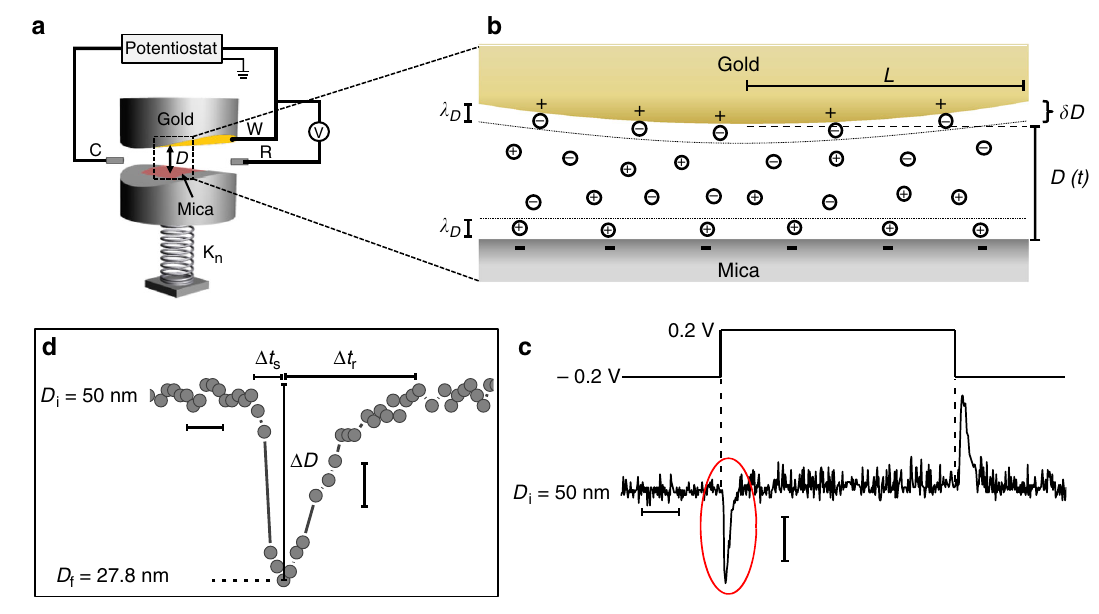
Fig. 1 a Schematic of the Surface Force Balance (SFB) and three-electrode con fi guration, with the principle components labeled, as described in detail in the experimental section. During measurements, the electrodes are immersed in an electrolyte solution inside a quartz bath, custom-designed to prevent leakage of current to the ground. Potentials applied to the gold surface were in the so-called double-layer range (i.e., where the electrode is ideally polarized), to ensure, crucially, the absence of any electrochemical reactions 44,45 (Supplementary note 5). b A section through the intersurface gap at closest separation D , showing its pore-like structure, where λ D is the Debye length, L is the radius of the circular pore, δ D is the change in pore width at a distance L from the pore center due to curvature of the surfaces ( δ D ≅ L 2 /2 R ). The schematic is not to scale: L is typically 100 μ m, while D is of order 100 nm, giving a (diameter/thickness) ratio of ca. 1000 for the pore/slit. c D ( t ) traces taken in 5 mM NaNO 3 at D = 50 nm based on video recording of the motion of the interference fringes in the SFB, in response to positive and negative potential steps as indicated by the upper potential trace. The obtained peaks re fl ect the movement of the lower surface (mica) in response to application of a positive ( ‒ 0.2 V → 0.2 V) or negative (0.2 V → ‒ 0.2 V) step potentials. Scale bars: horizontal – 2 s; vertical – 10 nm. d A magni fi ed view of the peak circled in red in the D ( t ) plot in ( c ), demonstrating its asymmetric shape, where Δ t s and Δ t r signify the initial motion and relaxation time, as shown, and Δ D is the distance shift from initial surface separation D i = 50 nm to extremal separation D f = 27.8 nm (prior to its relaxation back to D i ). Scale bars: horizontal – 0.2 s; vertical – 5